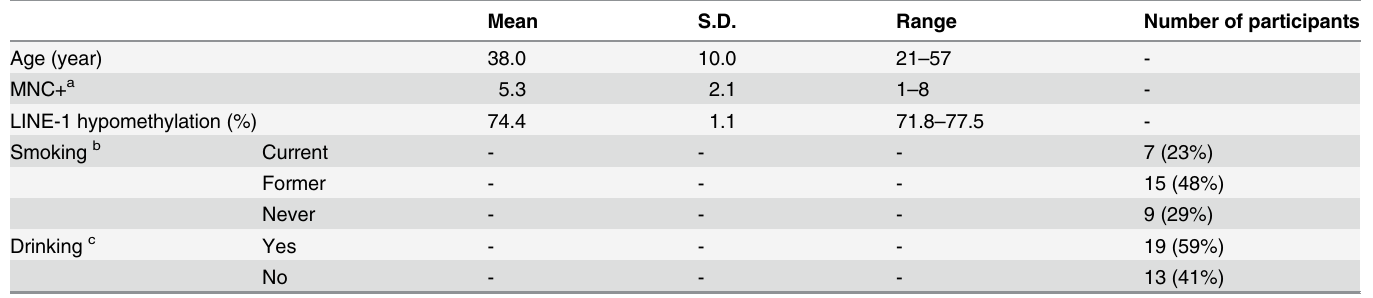
Table 1. Characteristics of the participants.